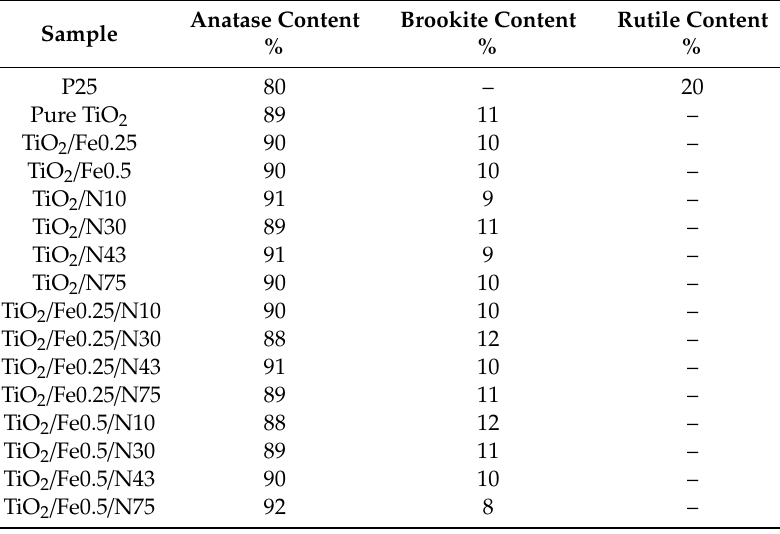
Table 2. Semi-quantitative analysis of sample